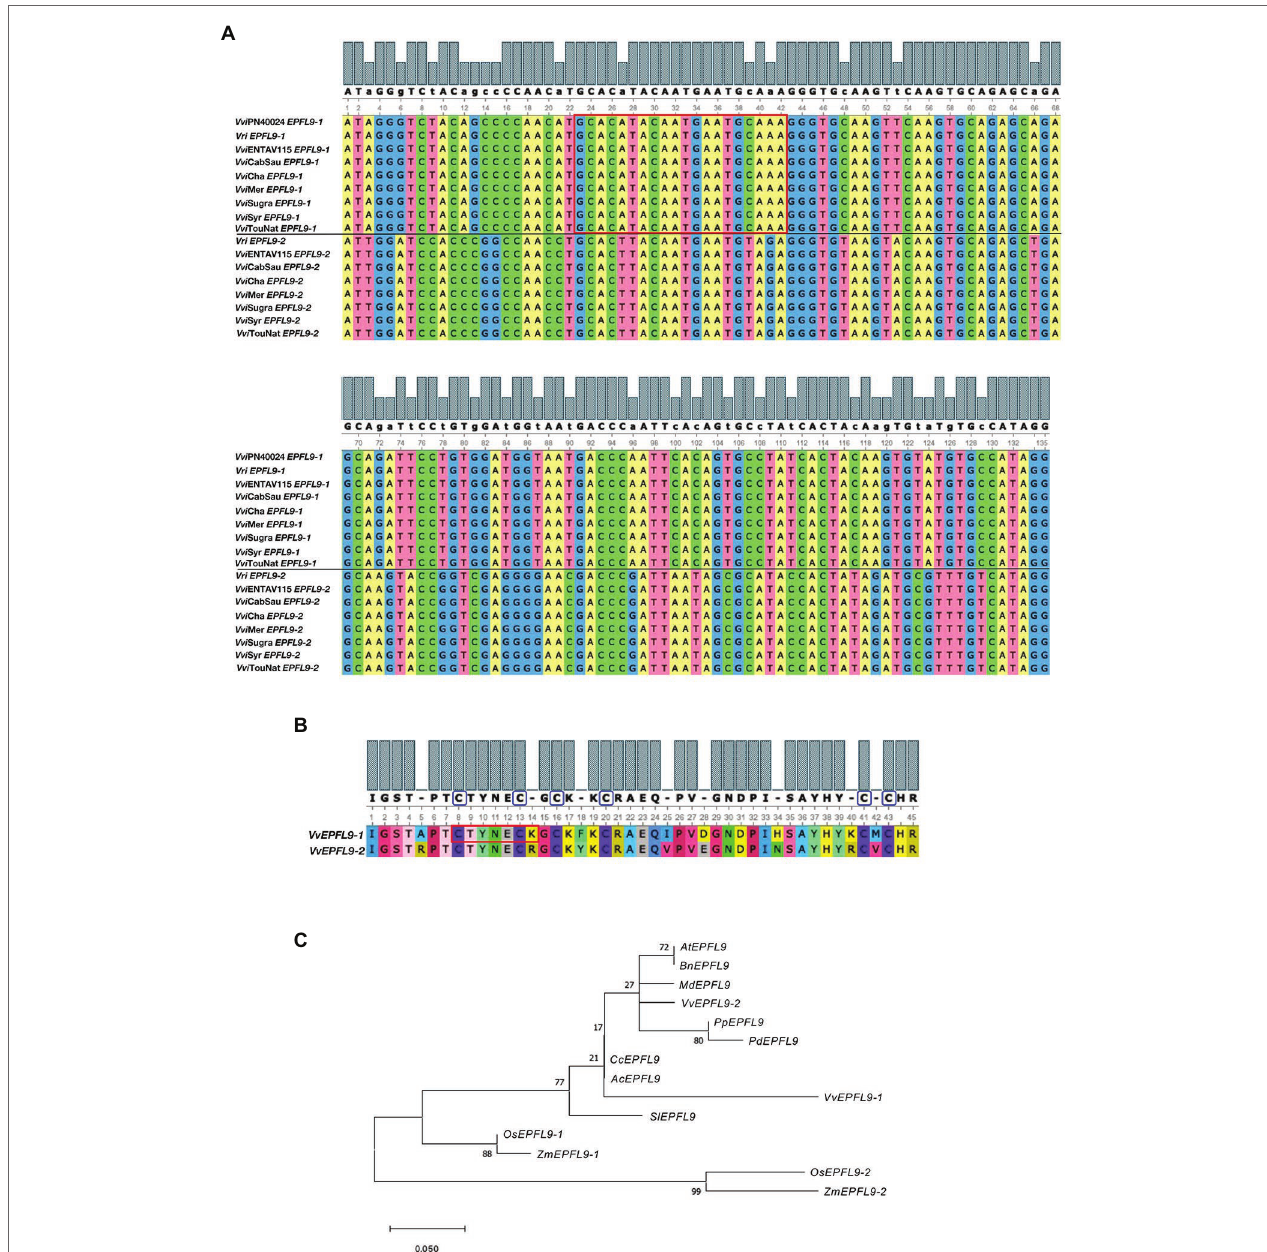
FIGURE 1 | Analysis of VvEPFL9 paralogs. (A) Alignment of the nucleotide sequence encoding for the C-terminal domain (135 bp) obtained by Sanger sequencing of PCR fragments amplified on genomic DNA with primers VvEPFL9-1_fw; VvEPFL9-1_rv and VvEPFL9-2_fw; VvEPFL9-2_rv (see primer list in Supplementary Table 2 ). Genomic DNA was extracted from leaves of ‘Pinot Noir PN40024’, Vitis riparia ‘Riparia Glorie de Montpellier’, ‘Pinot Noir clone Entav 115’, ‘Cabernet Sauvignon’, ‘Chardonnay’, ‘Merlot’, ‘Sugraone’, ‘Syrah’, ‘Touriga National’. The red rectangle indicates the 20 bp-target site recognized by the sgRNA/Cas9 complex. (B) Alignment of the C-terminal protein domain of VvEPFL9-1 and VvEPFL9-2, translated from the 135 bp nucleotide sequences shown in (A) . Cysteine residues are circled in blue. The red rectangle indicates the peptide region corresponding to the target site. (C) Phylogenetic tree of the Arabidopsis AtEPF9 mature peptide and its orthologs from some dicotyledonous ( Brassica napus , Malus × domestica , Vitis vinifera , Prunus persica , Prunus domestica , Prunus dulcis, Citrus clementina, Actinidia chinensis, Solanum lycopersicum ) and monocotyledonous ( Orytia sativa , Zea mays ) plant species. The alignments were generated with MUSCLE (MEGA X) and visualized with Unipro UGENE [http://ugene.net/faq.html (Okonechnikov et al., 2012)]. The phylogenetic tree was built with MEGA X using Maximum Likelihood (1,000 replicates bootstrap). Accession Numbers: VvEPFL9-1 ( Vitis vinifera ; Vitvi05g01370); VvEPFL9-2 ( Vitis vinifera ; contig VV78X057312.8. BioProject PRJEA18357); AtEPFL9 ( Arabidopsis thaliana ; AT4G12970); BnEPFL9 ( Brassica napus ; BnaA08g04900D-1); OsEPFL9-1 ( Oryza sativa ; BGIOSGA005039-TA); OsEPFL9-2 ( Oryza sativa ; BGIOSGA026626-TA); ZmEPFL9-2 ( Zea mays ; Zm00001d049795_T001); ZmEPFL9-1 ( Zea mays ; Zm00001d012079_T001); SlEPFL9 ( Solanum lycopersicum ; Solyc08g066610.3.1); MdEPFL9 ( Malus domestica ; mRNA:MD10G0128800); CcEPFL9 ( Citrus clementina ; ESR50459); PpEPFL9 ( Prunus persica ; ONH92727); PdEPFL9 ( Prunus dulcis ; VVA33635); AcEPFL9 ( Actinidia chinensis ;